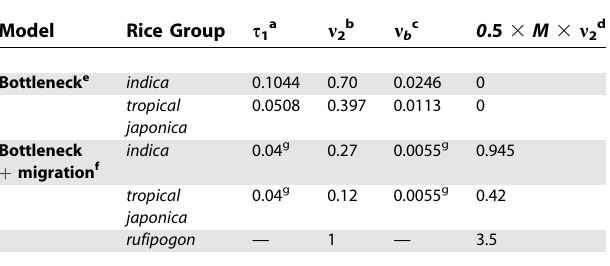
Table 2. Maximum Likelihood Estimates for Demographic Parameters of the Bottleneck and Bottleneck plus Migration Models in indica , tropical japonica , and O.